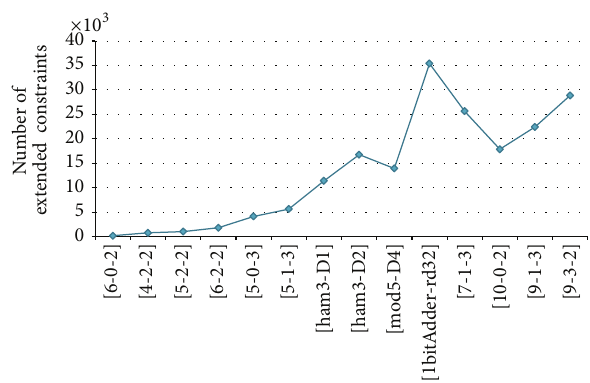
Figure 8: The number of extended constraints in each class of benchmarks.